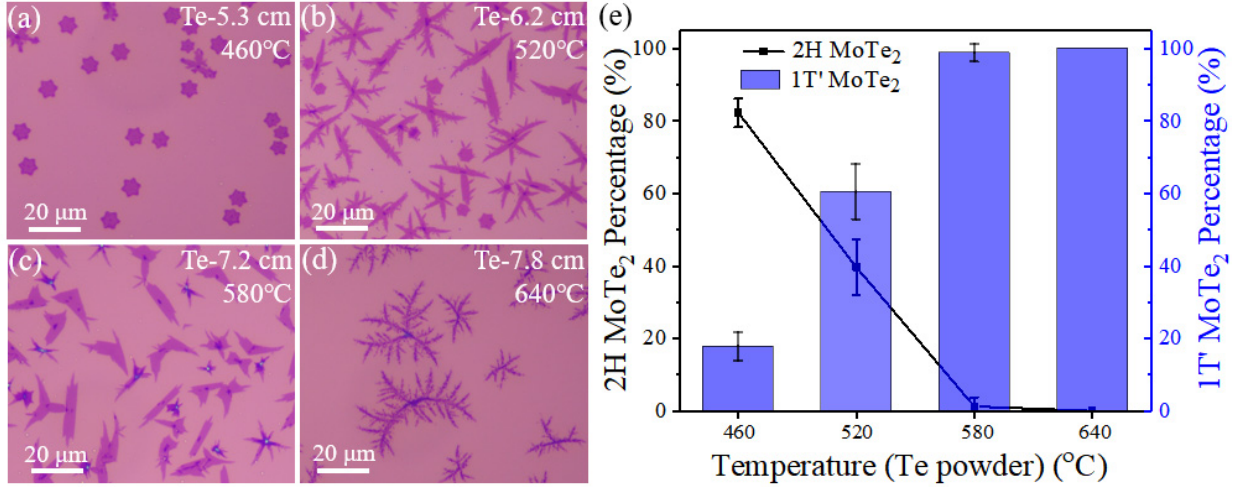
Figure 5. ( a – d ) Optical microscopic images of as-synthesized MoTe 2 by varying the location of Te powder (L, the distance from the heating-zone edge in the upstream direction), related to different heated temperatures. ( e ) Dependence of the phase percentage for few-layer 2H and 1T (cid:48) MoTe 2 as a function of the heating temperature of Te powder.